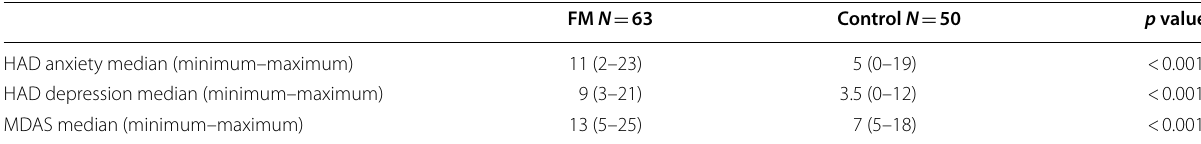
Table 3 Comparison of Fibromyalgia syndrome patients and control group in terms of anxiety and depression scale scores